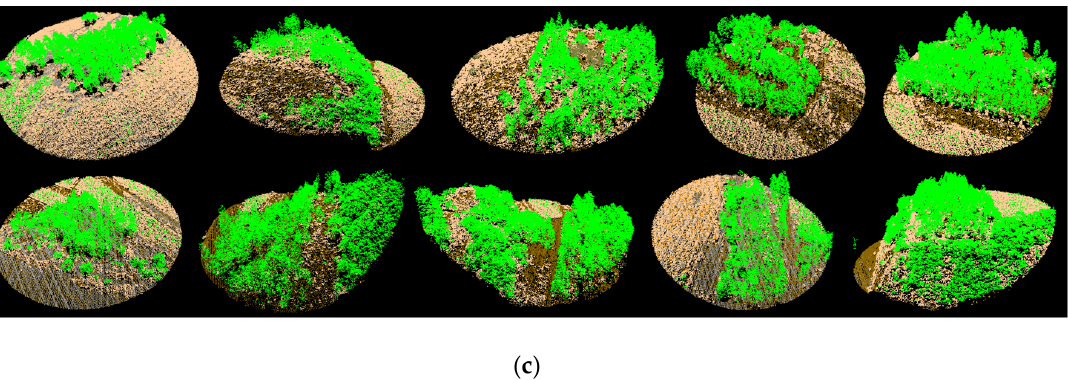
Figure 1. The information of the test site and the ten sample plots. ( a ) The location of the ten test plots. ( b ) The plots with green circles are selected for the experiment. ( c ) 3D overview map of LiDAR points data for the 10 test sample sites.